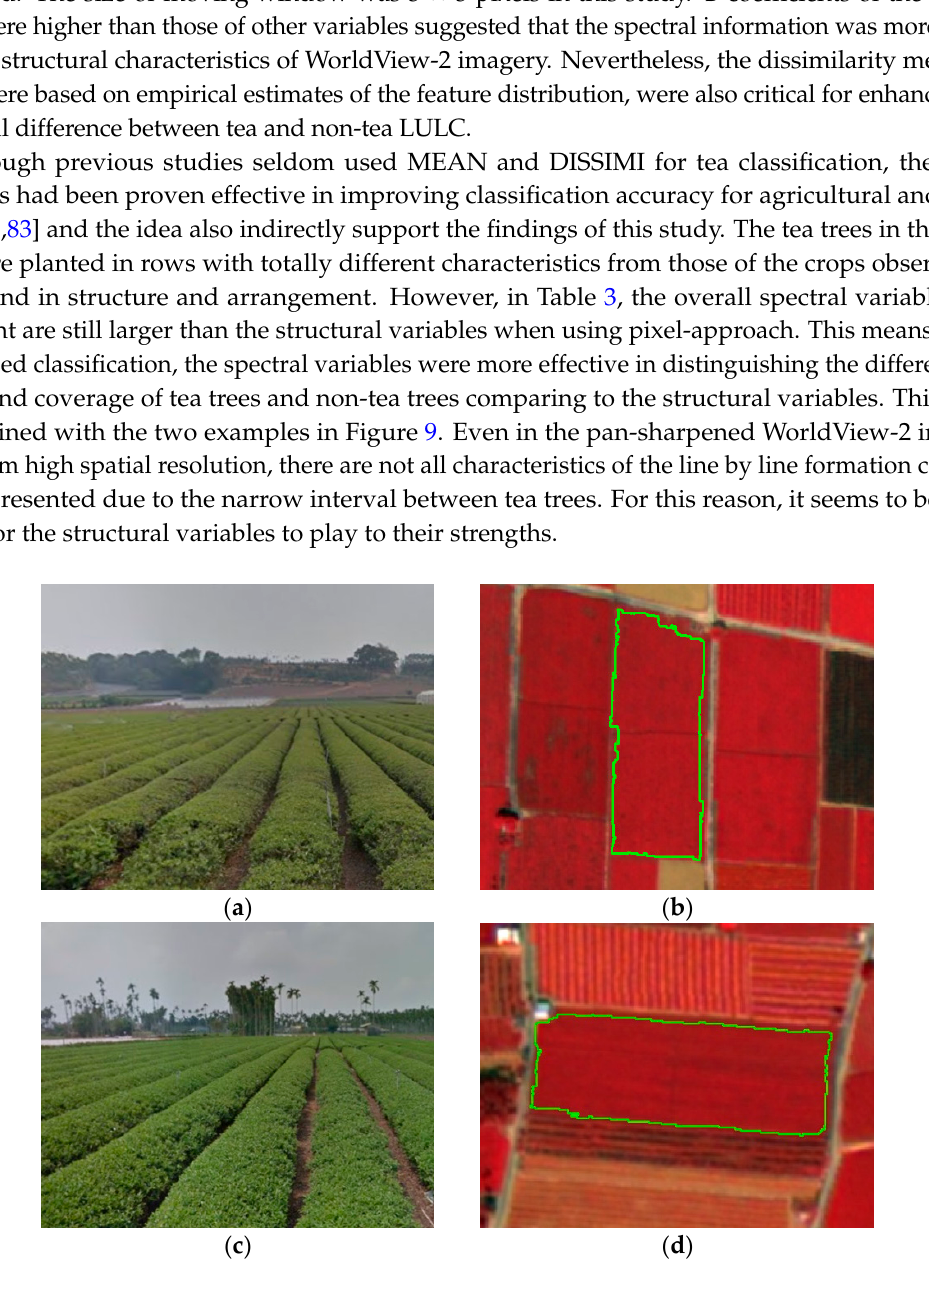
Figure 9. Comparative images of the photograph of the tea tree field (left row) and WorldView-2 (right row). ( a ) is the photograph captured in 120.6341°E, 23.8684°N in 4 March 2015 while ( b ) is its corresponding WorldView-2 image captured in 22 February 2015; ( c ) is the photograph captured in 120.6292°E, 23.8615°N in 5 March 2015 while ( d ) is its corresponding WorldView-2 image captured in 22 February 2015.